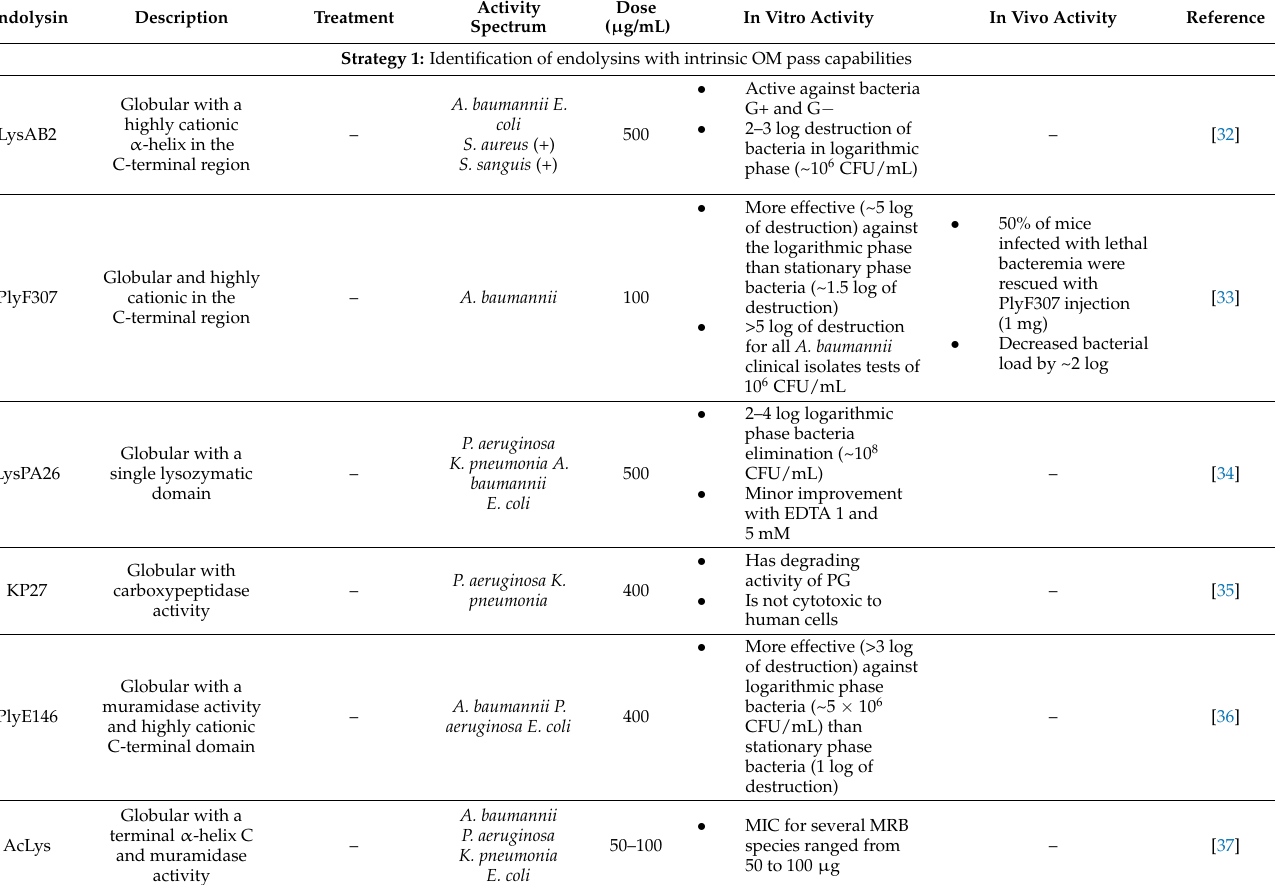
Table 2. Endolysins activity against bacteria of clinical and nutritional interest.